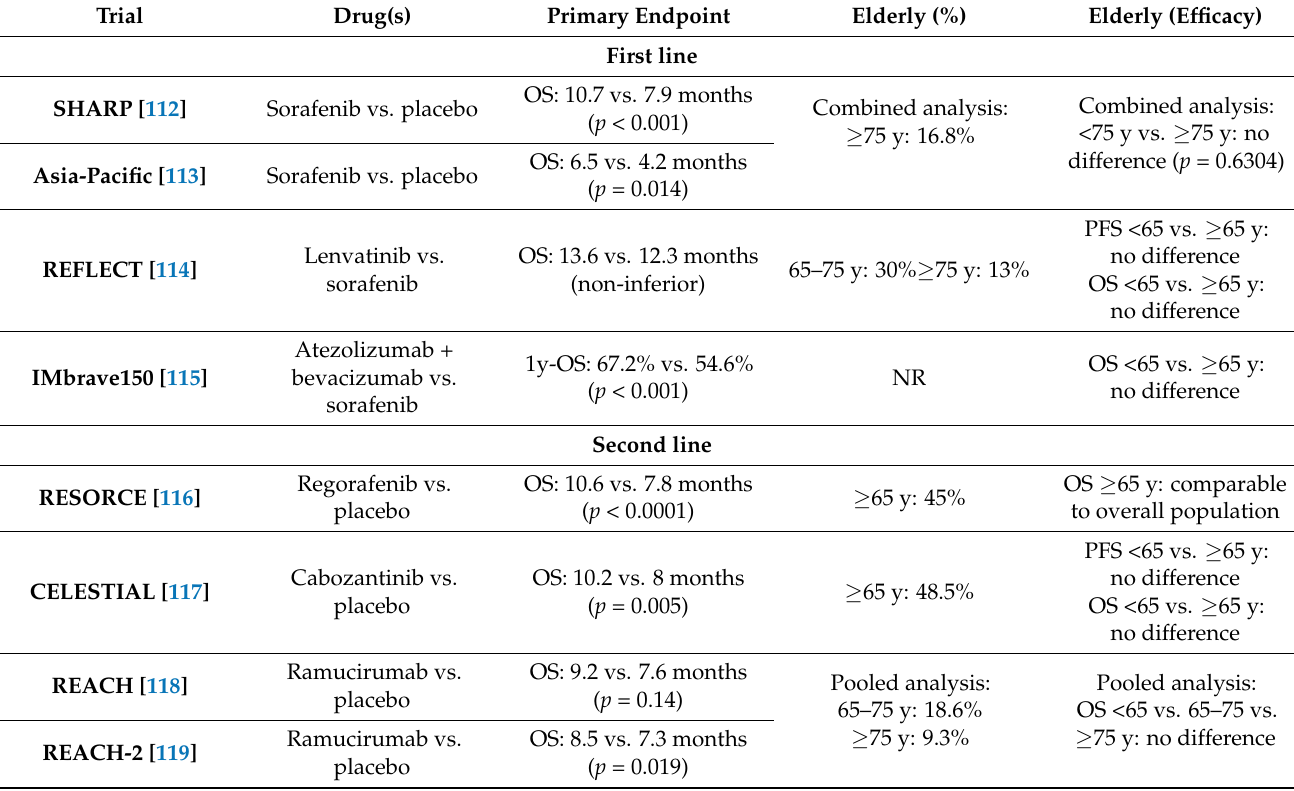
Table 1. Landmark trials for advanced HCC treatment in the first- and second-line settings with a focus on the elderly